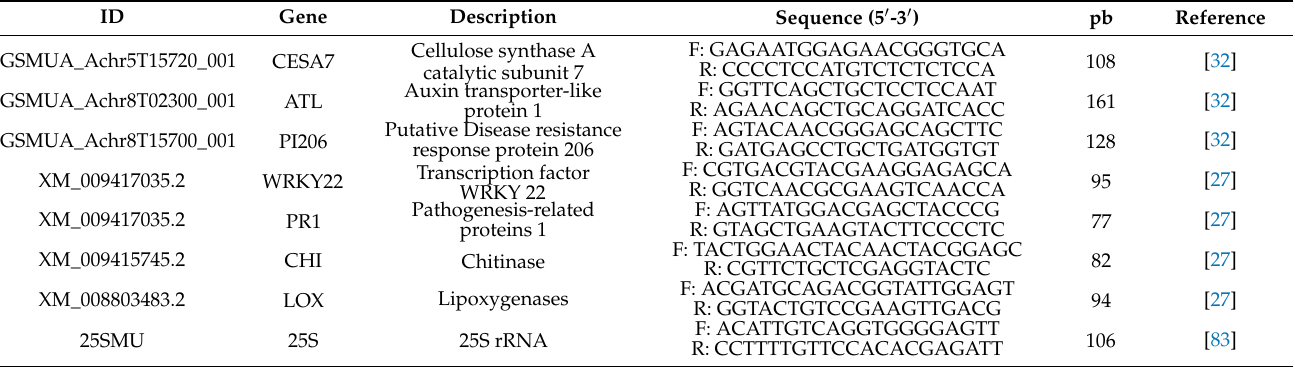
Table 1. Primers used in gene expression analysis of the interaction of banana cultivars and Fusarium oxysporum f. sp. cubense with different levels of